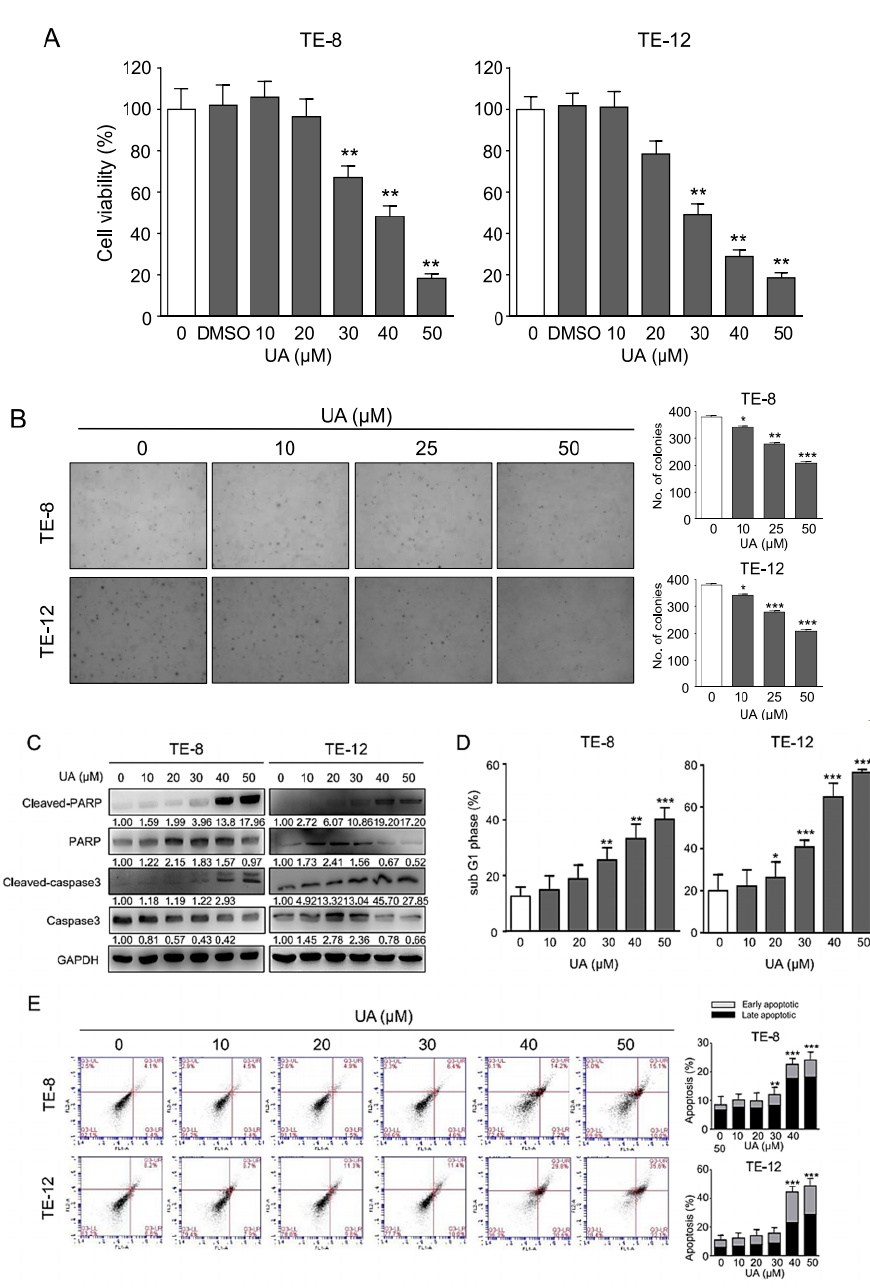
Figure 1. Ursolic acid (UA) inhibits the proliferation of esophageal squamous cell carcinoma (ESCC) cells. ( A ) Effect of UA on cell viability. TE-8 cells and TE-12 cells were treated with UA in a dose-dependent manner. The cells were then assayed with MTT. ( B ) Effect of UA on the colony formation ability of ESCC. The number of colonies formed significantly decreased after UA treatment in a dose-dependent manner in both the TE-8 and TE-12 ESCC cells. Scale bar = 500 µ m ( C ) UA induced the expression of cleaved-PARP and cleaved-caspase-3 in the TE-8 cells and TE-12 cells in a dose-dependent manner and decreased the expression of PARP and caspase-3. We employed glyceraldehyde 3-phosphate dehydrogenase as an internal control. ( D ) Induction of sub-G1 phase was analyzed by propidium iodide staining with a flow cytometer. ( E ) Cell apoptosis was detected by fluorescein isothiocyanate–annexin V staining with a flow cytometer. Apoptotic cells were increased in a dose-dependent manner by UA. The data are presented as the mean ± SE for three independent experiments. * p < 0.05, ** p < 0.01, and *** p < 0.001 compared with the